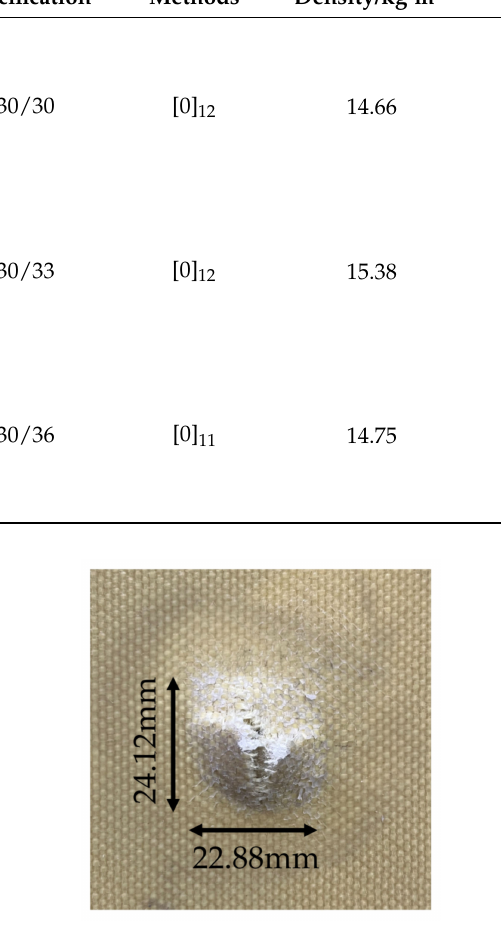
Figure 13. The details of the